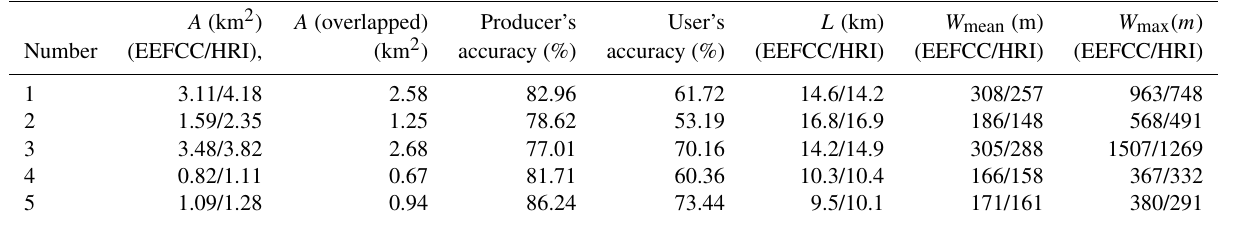
Table 6. Comparison of windthrow geometrical parameters estimated using the EEFCC and HRI